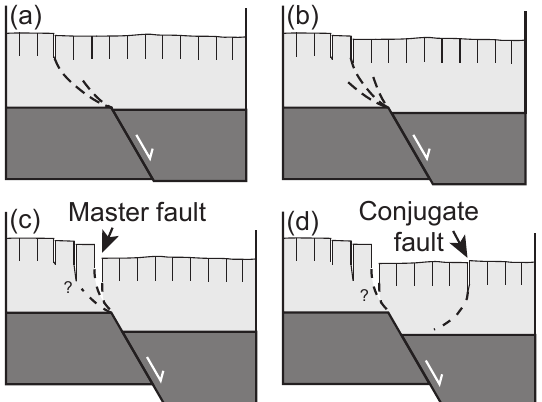
Figure 6. Conceptual sketch illustrating the development of a typi- cal joint controlled fault zone in side